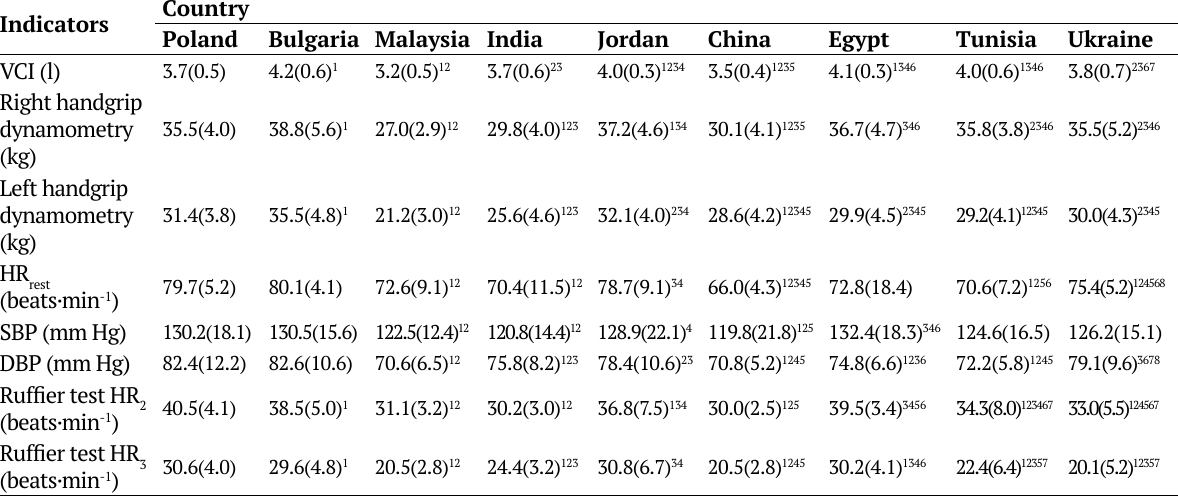
Table 2. Physiometric indicators of students, х (SD)